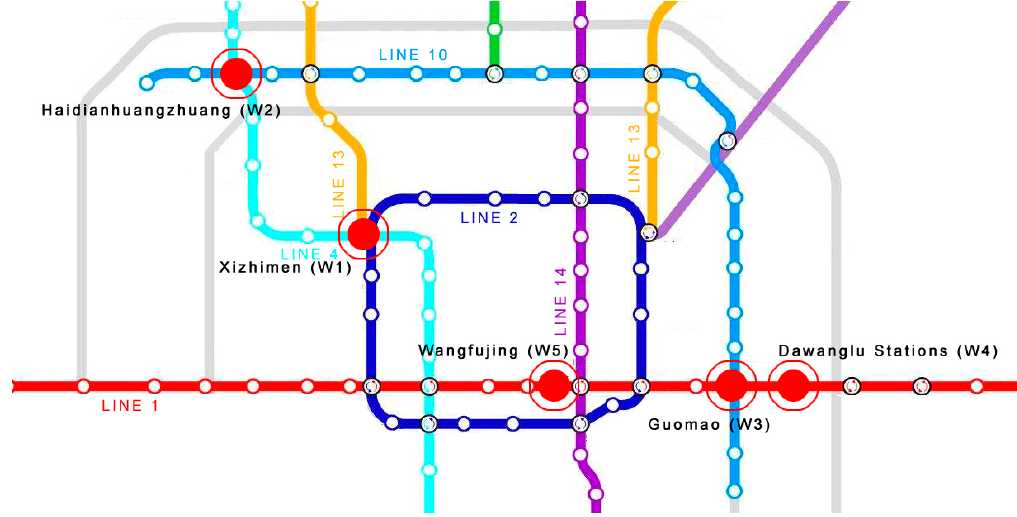
Figure 4. Five typical subway station building complexes in Beijing.